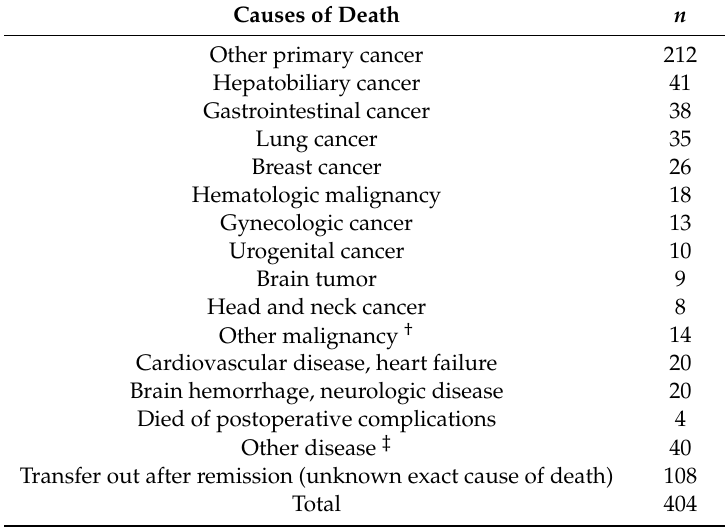
Table 1. Causes of death in 483 patients who died with well-di ff erentiated thyroid carcinoma. Causes of Death n